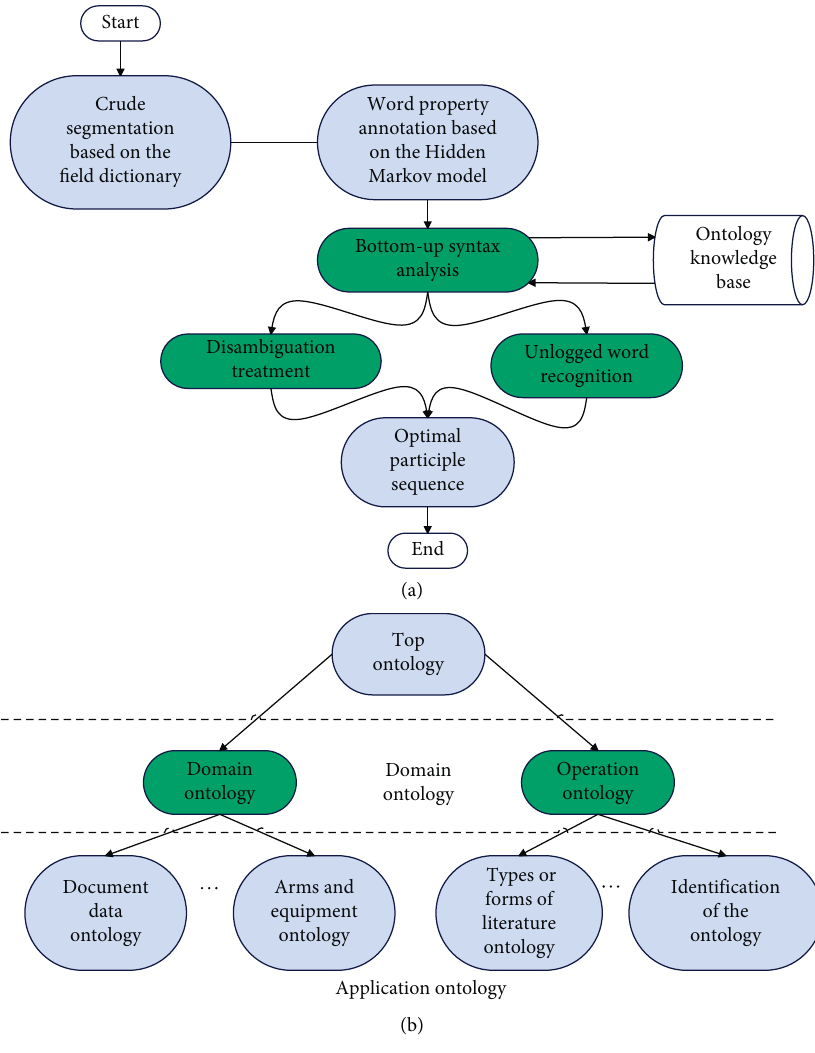
Figure 7: Word segmentation level model. (a) Word segmentation framework. (b) Ontology